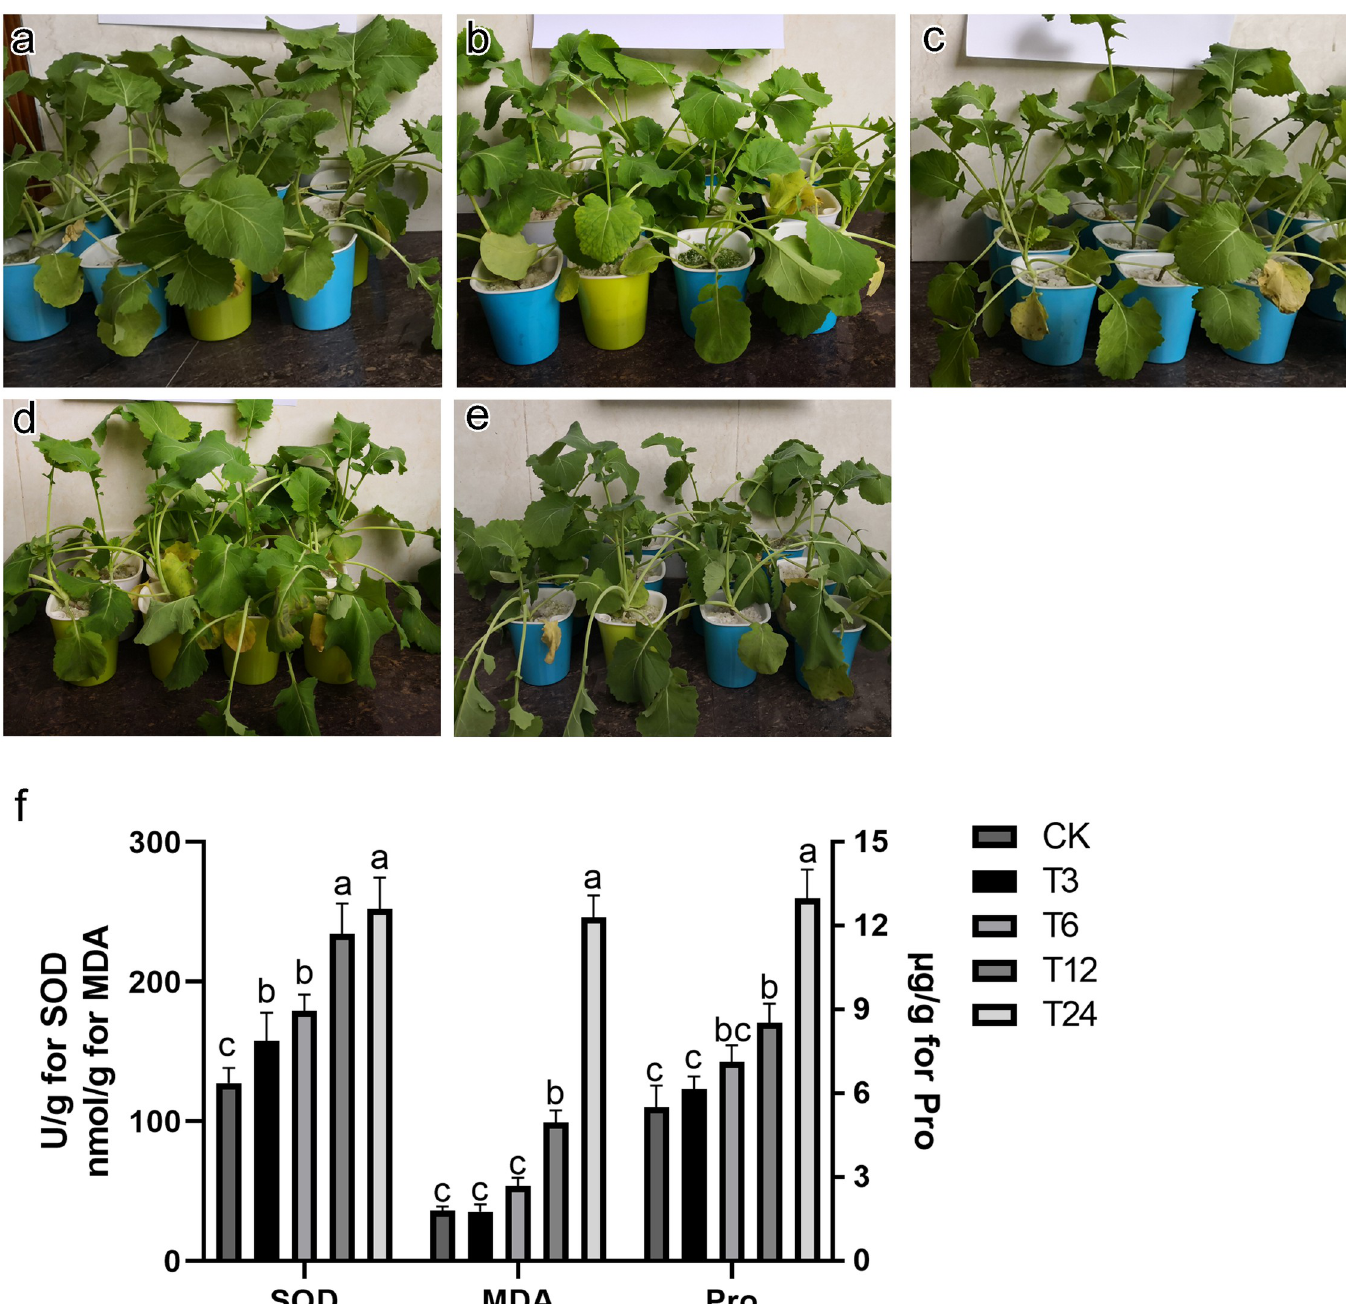
Fig 1. Effects of salt stress on phenotype and physiological indexes. (a) to (e) shows the phenotype of Brassica napus seedlings treated with salt stress. (a) to (e) represents CK, T3, T6, T12 and T24 groups, respectively. (f). The image shows the total superoxide dismutase activity (SOD, left-hand ordinate), malondialdehyde levels (MDA, left-hand ordinate) and the amount of proline (Pro, right-hand ordinate) in different groups. Identical letters indicate the absence of a significant difference ( p > 0.05) and different letters indicate a significant difference ( p < 0.05). T24, respectively ( S1C Fig ). The number of DEGs increased with the duration of salt treat- ment. The Venn analysis results showed that only 68 genes are commonly expressed in all the comparisons ( S1D Fig ).